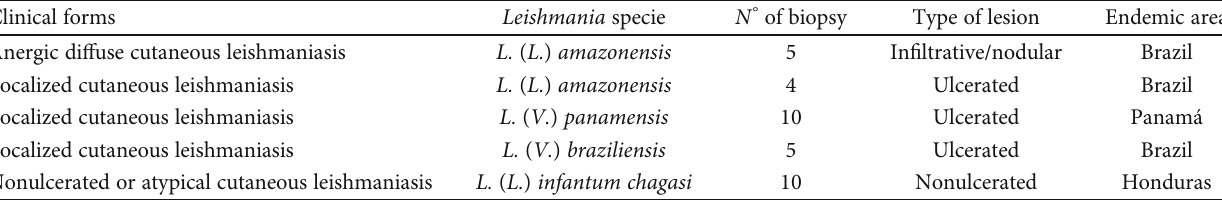
Table 1: Characteristics of the samples used in the present